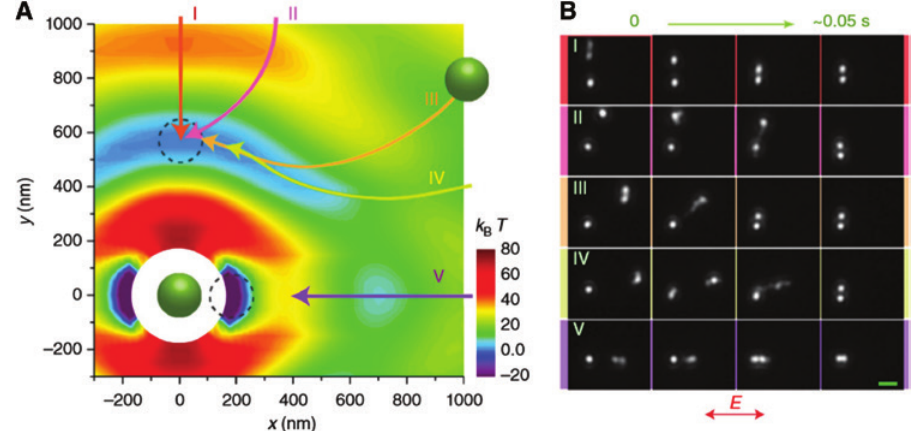
Figure 5: Path-dependent self-organisation of two 150 nm diameter Ag nanoparticles, using 800 nm radiation. (A) Electrodynamic potential energy surface and illustrated paths of the second particle entering the optical fi El. Units of k T = 293 K. (B) Corresponding optical images from five experiments in which the second particle enters from different directions. Scale bar, 1 μ m. Reproduced with permission from